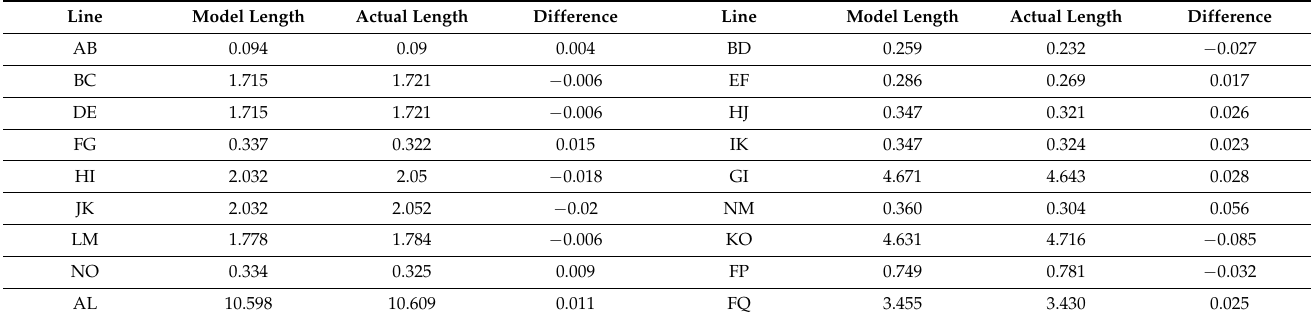
Figure 8. Line position map for comparing 3D model and in situ field. The letters A–Q indicate the location of the points, and the length of the line segment connecting the two points is measured and compared in this study. Table 7. Three-dimensional model and actual line length difference (unit: